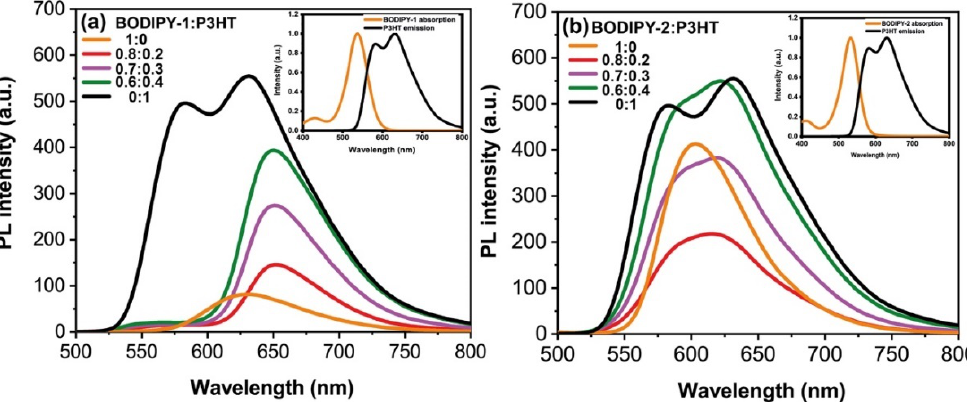
Figure 8. PL spectra of ( a ) P3HT/ BODIPY-1 co-solution in chloroform and ( b ) P3HT/ BODIPY-2 co-solution in chloroform. All samples were excited at 450 nm. Inset: absorption spectrum of BODIPY (orange line) and emission spectrum of P3HT (black line).